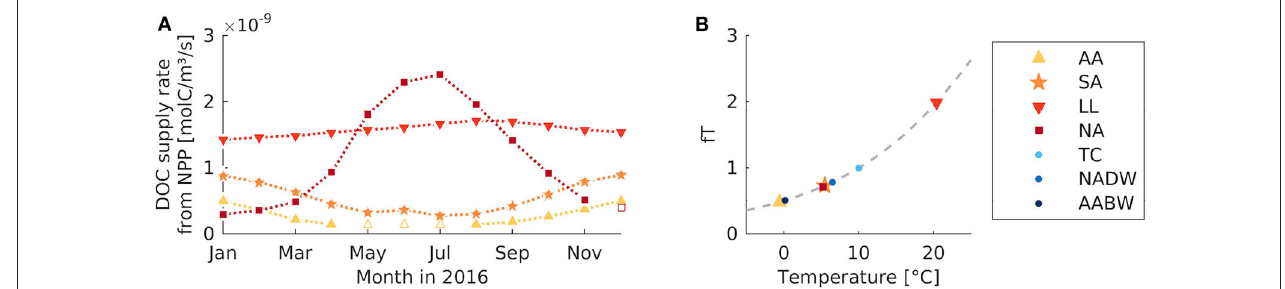
FIGURE 2 | Modifications to the model including seasonal supply or temperature dependent uptake. (A) Monthly DOC supply rate in the four surface boxes, estimated based on NPP data from Behrenfeld and Falkowski (1997, section 2.3). Open symbols indicate interpolated values. (B) Temperature response factor for microbial uptake as a function of box temperature (AA, Antarctic surface water; SA, Sub-Antarctic surface water; LL, Low-latitude surface water; NA, North Atlantic surface water; TC, Thermocline; NADW, North Atlantic deep water; AABW, Antarctic Bottom Water). The gray dashed line indicates the response function as defined by Blackford et al. (2004).